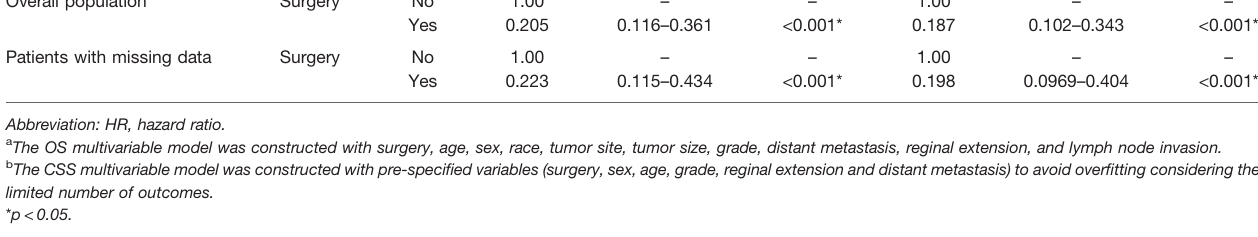
Patients with missing